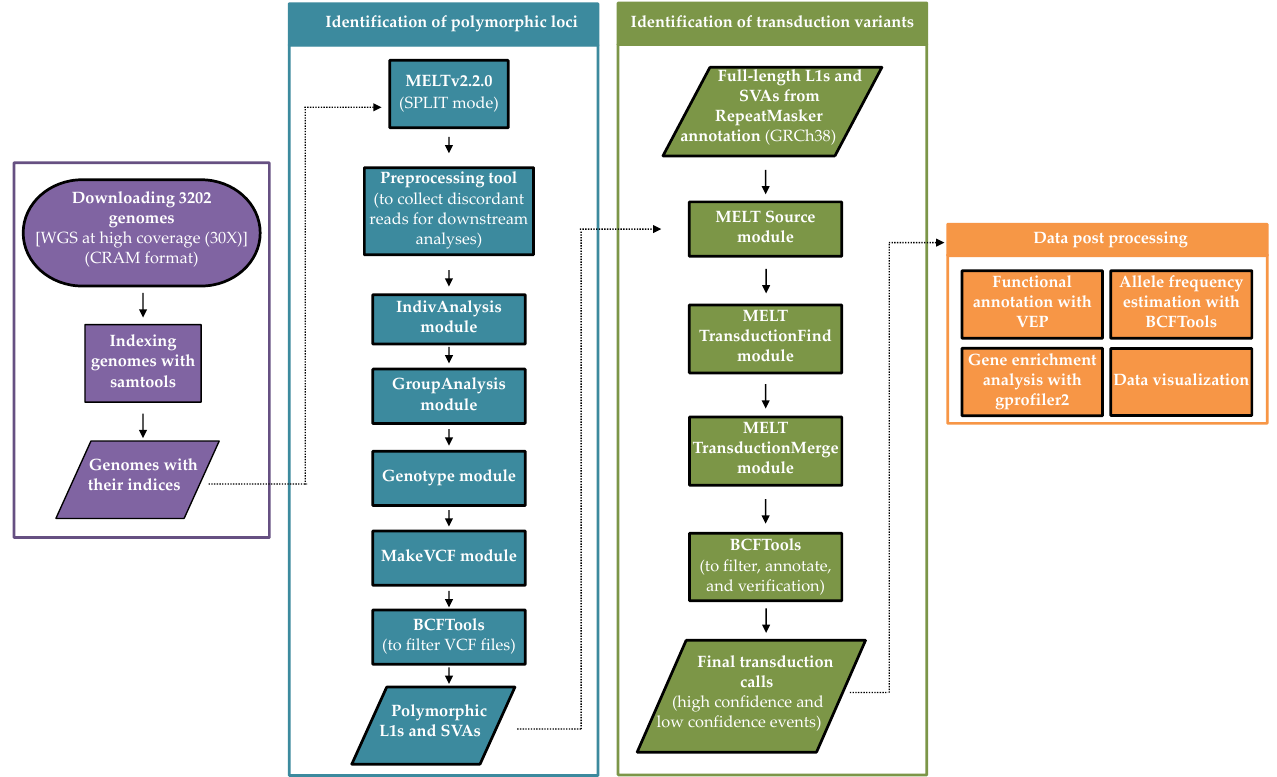
Figure 1. Schematic overview of the applied workflow to identify and characterize 3 (cid:48) DNA transduc- tions mediated by non-LTR